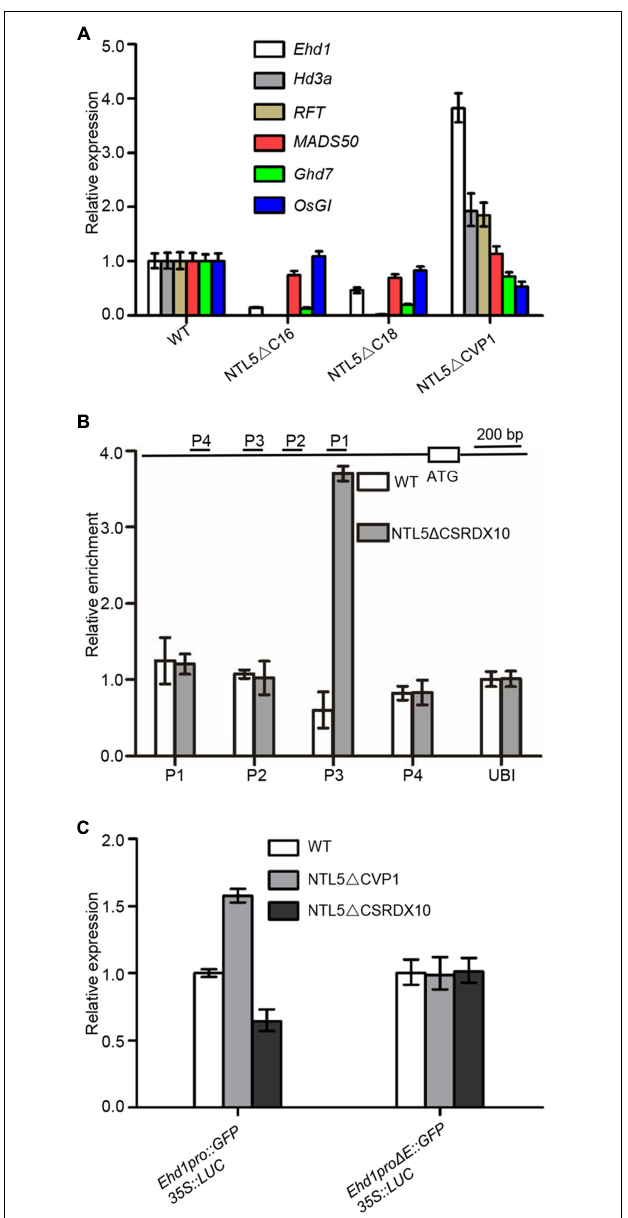
FIGURE 4 | OsNTL5 negatively regulates the Ehd1 transcript. (A) Expression analyses of Ehd1 , Hd3 , RFT , MADS50 , Ghd7, and OsGI transcripts in OsNTL5 (cid:49) C transgenic line 16#, 18# and OsNTL5 (cid:49) C-VP transgenic line 1# by qRT-PCR. Ubiquitin (Os03g13170) was used as an internal control. The qRT-PCR experiments were performed in three biological replicates. The data were means ± SD (standard deviation). (B) ChIP binding assay of OsNTL5 with the promoter of Ehd1 . Immunoprecipitation (IP) was pulled down by the anti-HA antibody in NTL5 (cid:49) C-SRDX10 transgenic plants. In control, immunoglobulin G was used to precipitate the same plant materials and the value of PCR was set as 1. (C) Effect of OsNTL5 on transcriptional regulation of Ehd1 in rice protoplasts. Ehd1pro (cid:49) E stands for deletion of the one cis -element (CTCCACGT) on the promoter of Ehd1 (at -1490 upstream from the start codon at the primer set P3). 35S::Luciferase was as an internal control. The OsNTL5 on transcriptional regulation of Ehd1 experiments were performed in three biological replicates. The data were means ± SD (standard deviation).